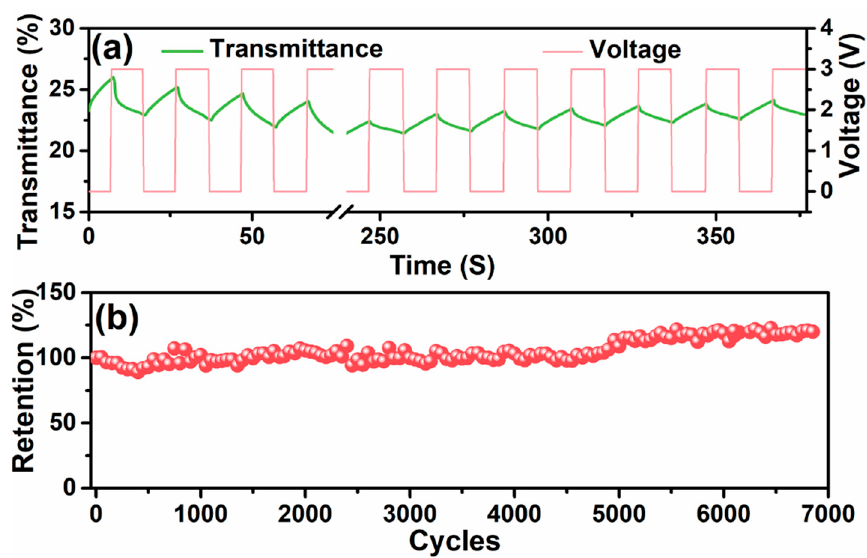
Figure 6. The cycling performance of the ESC device. ( a ) The transmittance-time profile of the device at 500 nm under square potential input between 0.0 V and 3.0 V at regular intervals of 10 s; ( b ) the capacitance retention of the device in the charge–discharge cycles at 1 A/g.